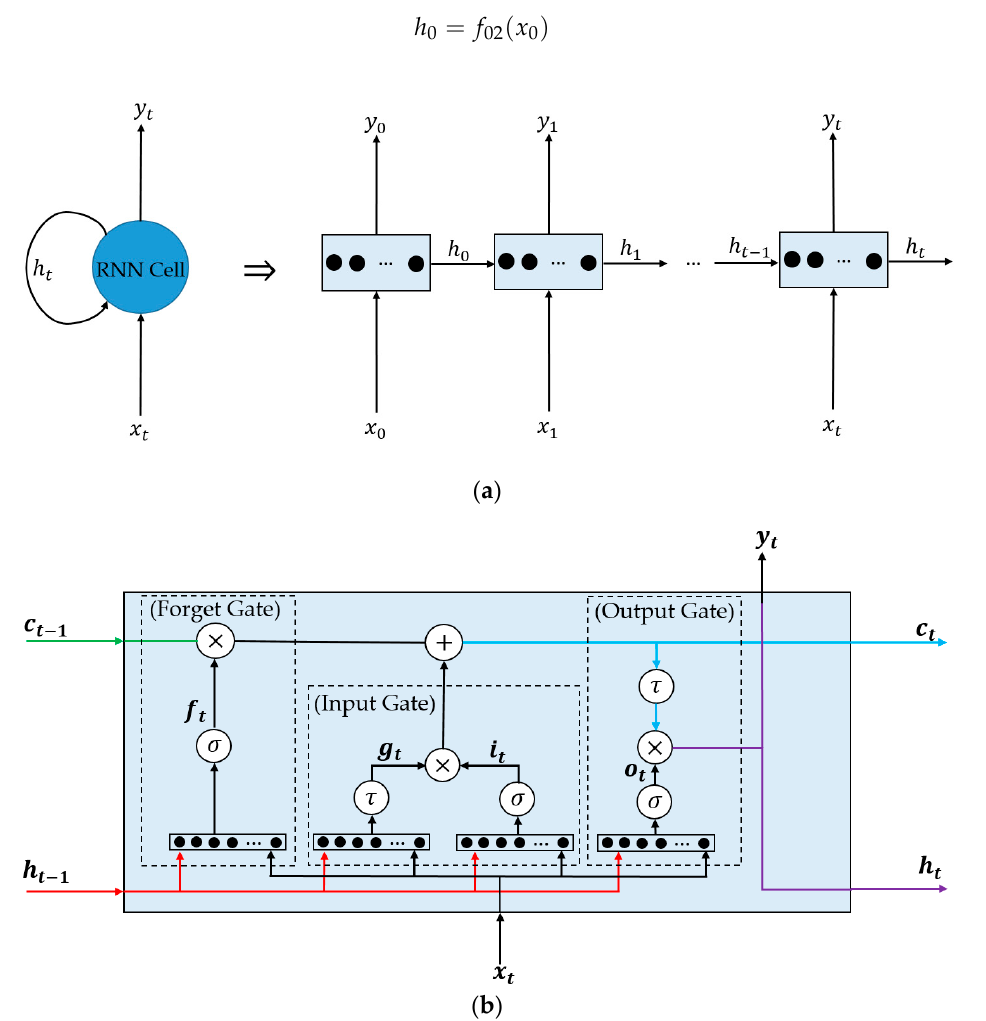
Figure 3. Demonstration of an RNN network: ( a ) a simple RNN cell; ( b ) structure of a standard LSTM cell.